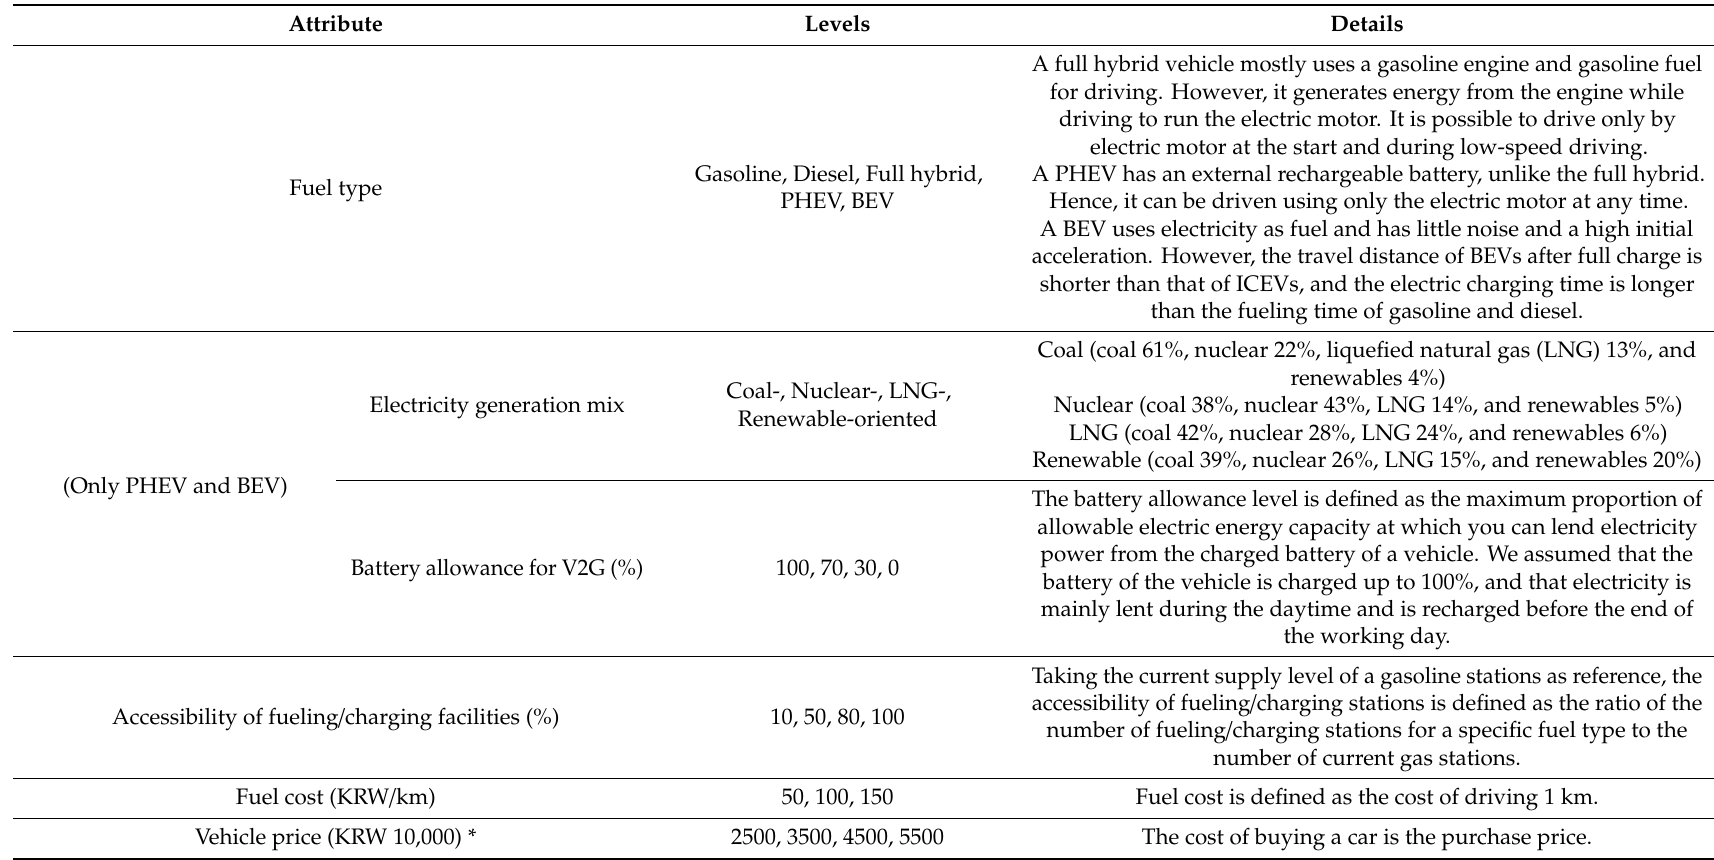
Table 2. Attributes and levels of vehicles for the conjoint